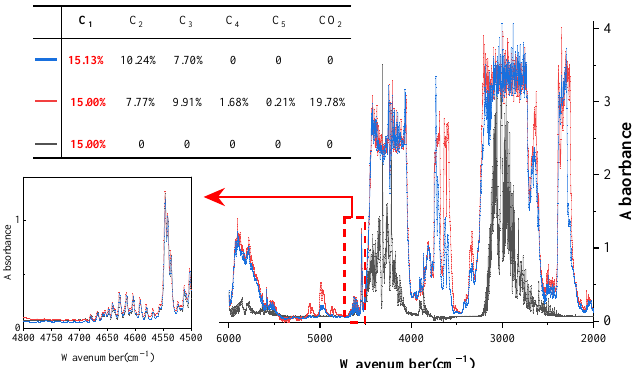
Figure 10. The IR spectra of three different samples with the same concentration of C 1 and the modelling interval selected by ASS-PLS (the red dotted box). The black line represents a sample in the one-component dataset. The red line represents a sample in the three-component dataset. The blue line represents a sample in the six-component